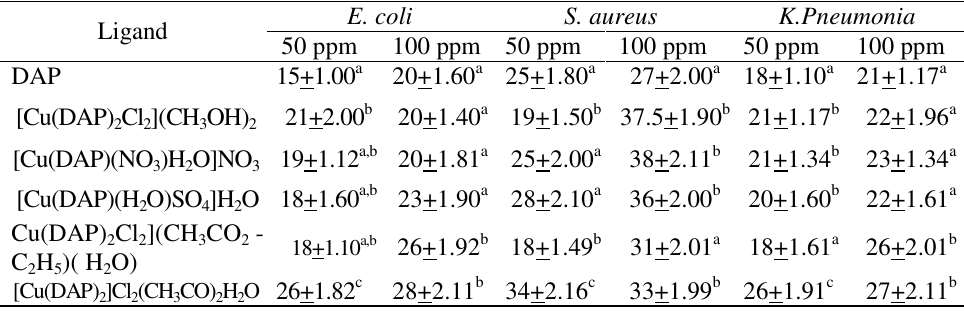
Table 4 . Antibacterial Screening Data of 4, 4–diaminodiphenylsulphone and its Complexes.